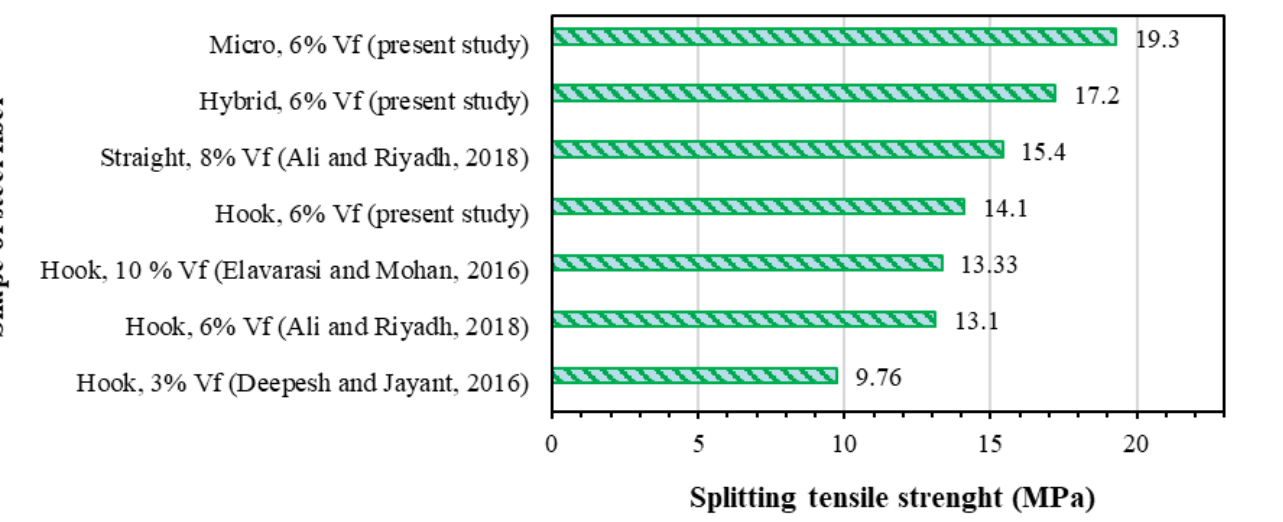
Figure 8. Comparison between the tensile strength of SIFC and the literature at 28 days. Figure 10. Comparison between the tensile strength of SIFCON and the literature at 28 days.